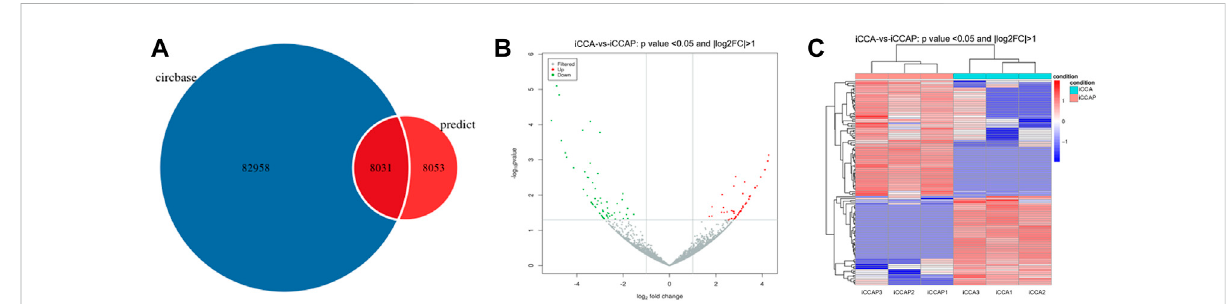
FIGURE 2 Identi fi cationoftheDEcircRNAs fromtheiCCA vs.iCCAP. (A) TotalcircRNAsidenti fi edfromthesixsamples werecomparedwiththeCircBase. (B) Volcano plots showing the DE circRNAs in iCCA and iCCAP. The red and green points represent the DE circRNAs. (C) Heatmaps representing the mean-centered and normalized data relative to the DE circRNAs in iCCA and iCCAP with p -value < 0.05 and log2FC > 1.